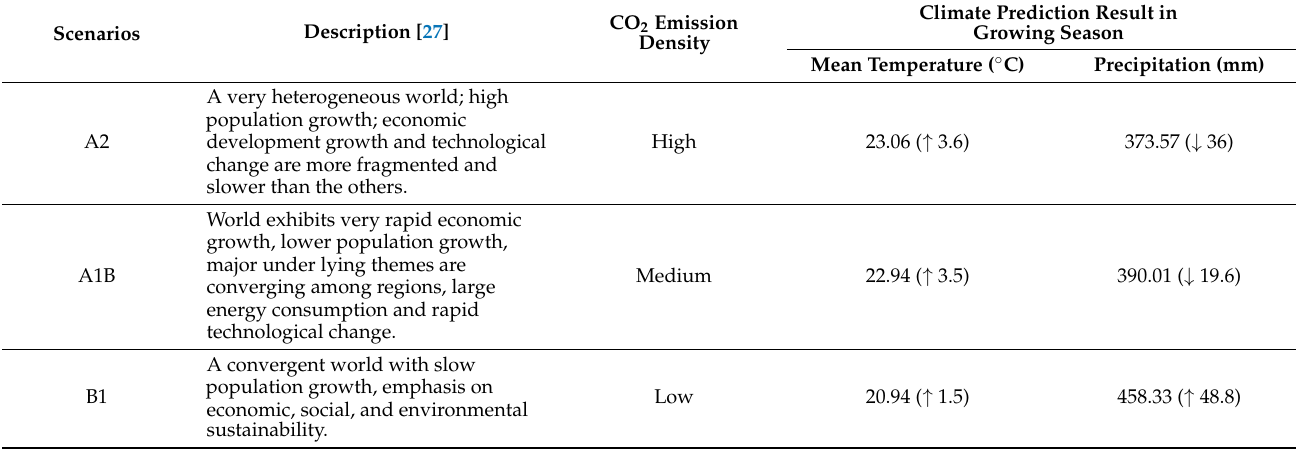
Table 1. Description and climate prediction results of future climate change scenarios.